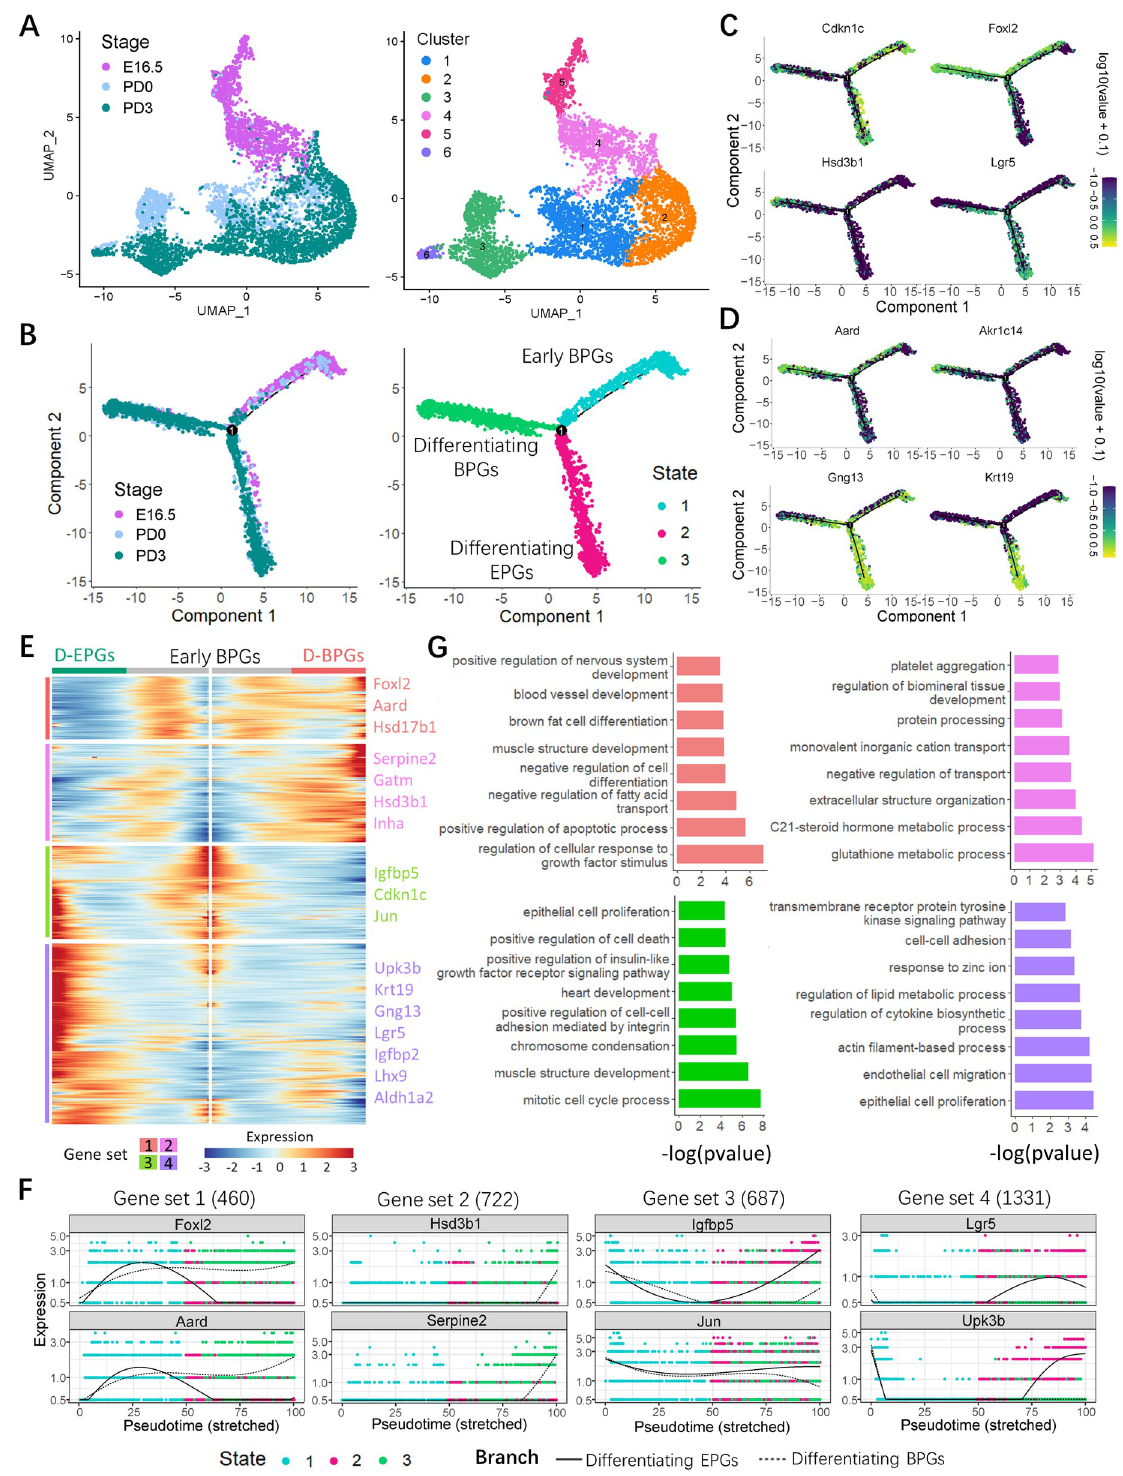
Fig 6. Molecular characterization of granulosa cell subsets. ( A ) Cluster analysis of granulosa cells with UMAP plots based on developmental timeline (left) and cell clusters (right). ( B ) Single-cell trajectories of granulosa cell subsets as a function of developmental timeline and cell States. ( C ) Expression of developmental marker genes along with pseudotime trajectories. ( D ) Expression of Aard , Akr1c14 , Gng13 , and Krt19 along with pseudotime trajectories. ( E ) Heatmap of the gene expression programs of pre-granulosa cell with